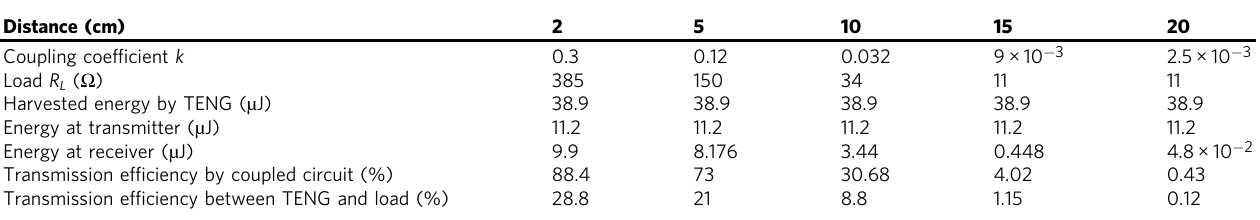
Table 2 Performance summary for a MR-WTENG with the coil diameter of 10 cm. Inductance of both the coils is 62.5 μ H, C 2 = 140